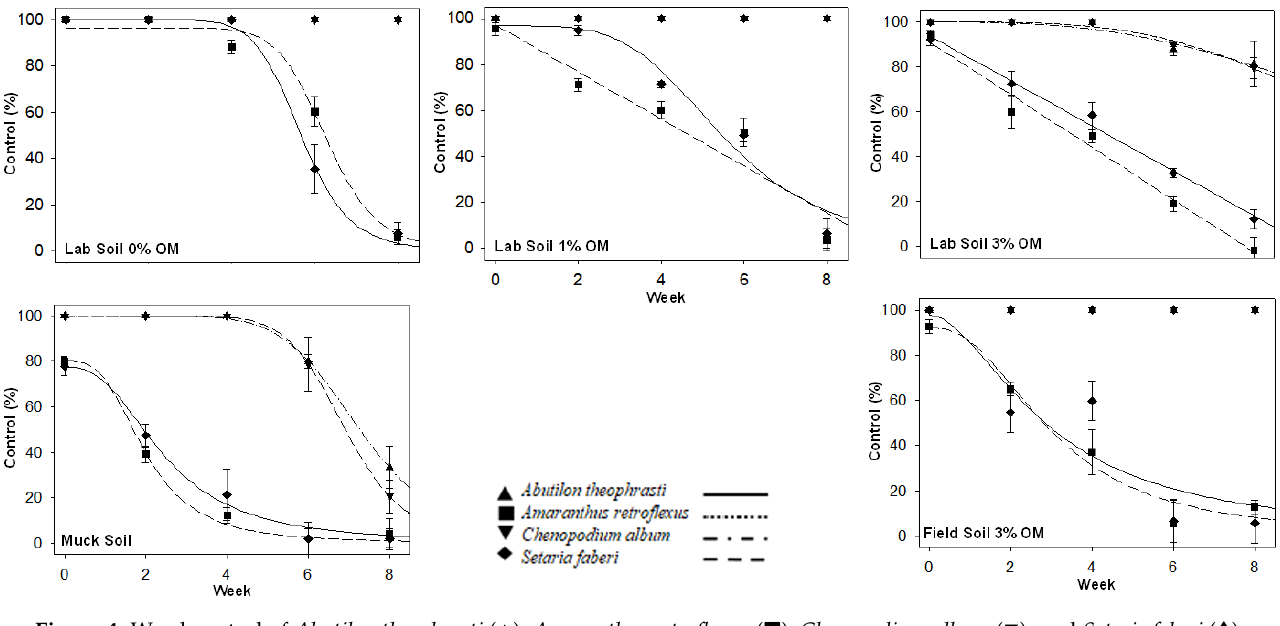
Figure 4. Weed control of Abutilon theophrasti ( ▲ ), Amaranthus retroflexus ( ■ ), Chenopodium album ( ▼ ), and Setaria faberi ( ♦ ) with flumioxazin as affected by percent soil organic matter over time for lab and field soils. Fitted lines for expected control are calculated by linear ( y = a + bx ) or logistic regression ( y = a /(1 + ( x / b )^ c )) for Abutilon theophrasti , Amaranthus retroflexus , Chenopodium album , and Setaria faberi . Error bars represent the standard deviation of the mean.